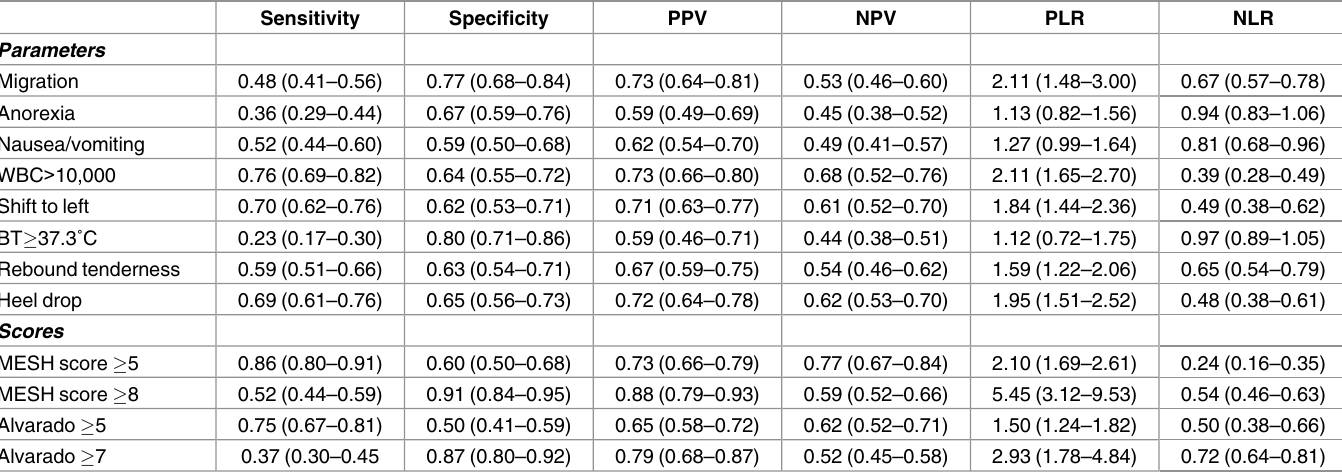
Table 4. Performance of the parameters included in the Alvarado score, heel drop test, calculated MESH score, and the Alvarado score * .